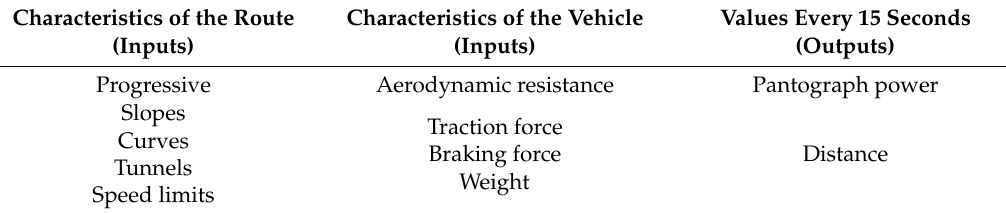
Table 1. Inputs and outputs of train performance simulation.